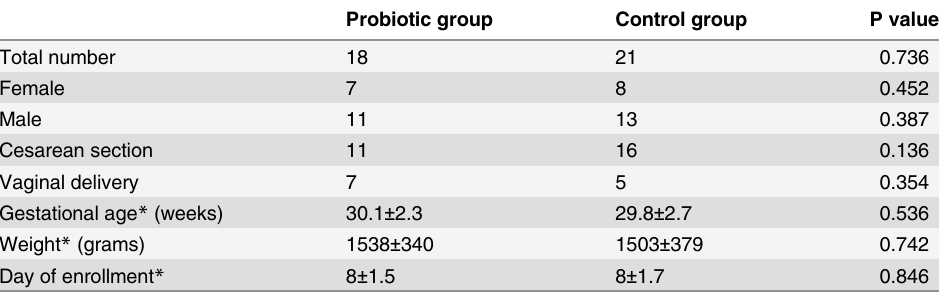
Table 1. Characteristics of the studied groups of infants.